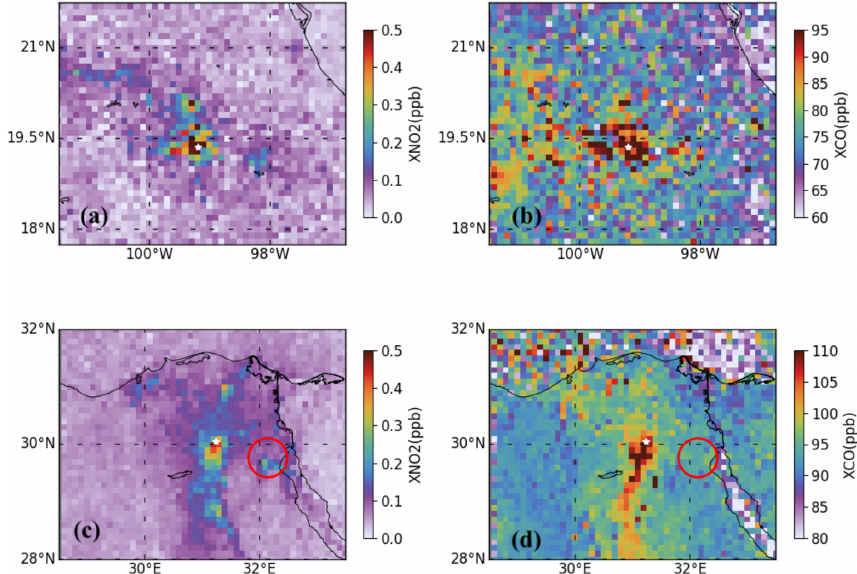
Figure 3. Co-located TROPOMI-retrieved XNO 2 (a, c) and XCO (b, d) data over Mexico (a, b) and Cairo (c, d) averaged for June to August 2018. De-striping is applied to CO total columns (Borsdorff et al., 2018b), and CO and NO 2 retrievals have been re-gridded to 0.1 ◦ × 0.1 ◦ . The white stars represent the centres of Mexico City and Cairo respectively. The red circle in (c) and (d) points to an industrial area east of